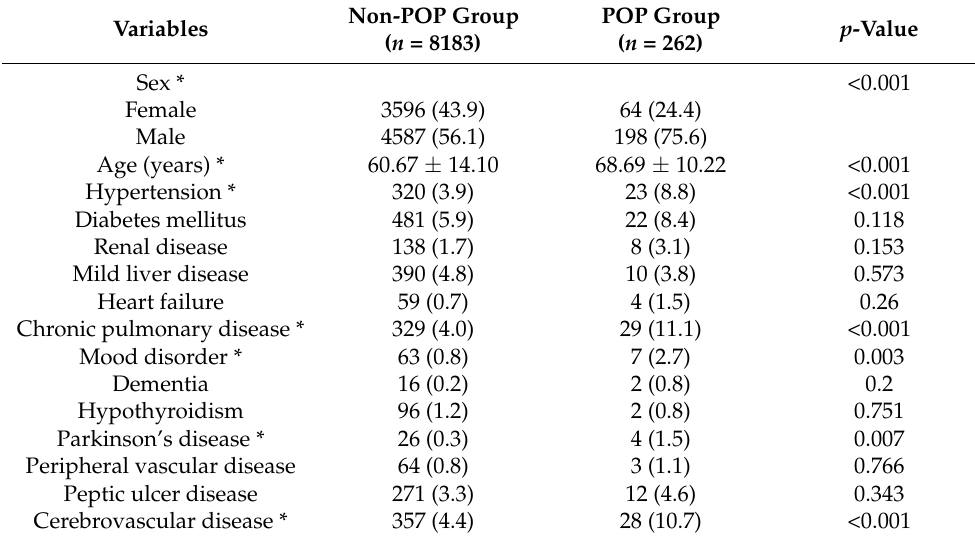
Table 1. Patient demographic data.